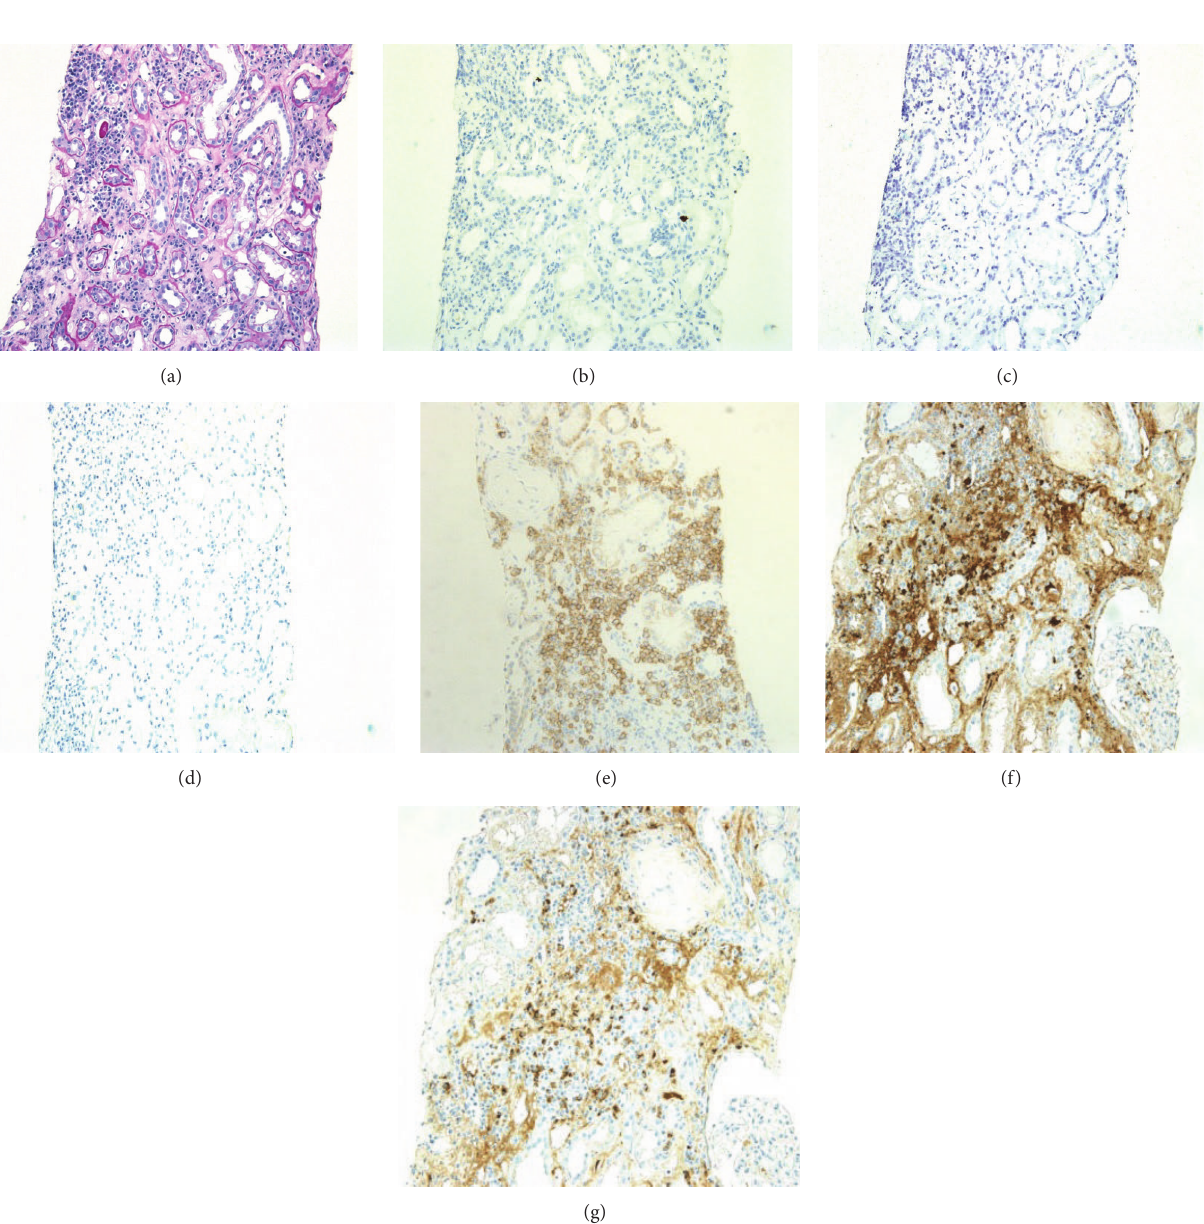
Figure 2: Light microscopic findings for a 3-month protocol biopsy specimen. (a) Mononuclear inflammatory cell infiltration was seen in the interstitial lesions, with plasma cells accounting for approximately 20%. Moderately developed tubulitis was noted in the middle of the field (PAS, × 200). (b–d) Negative staining of SV40 (b), EBER (c), and IgG4 (d) in allograft specimen ( × 200). (e) CD138-positive interstitial inflammatory cells ( × 200). (f, g) Infiltrating plasma cells positive for both kappa (f) and lambda (g) light chains, indicating that they are polyclonal ( ×